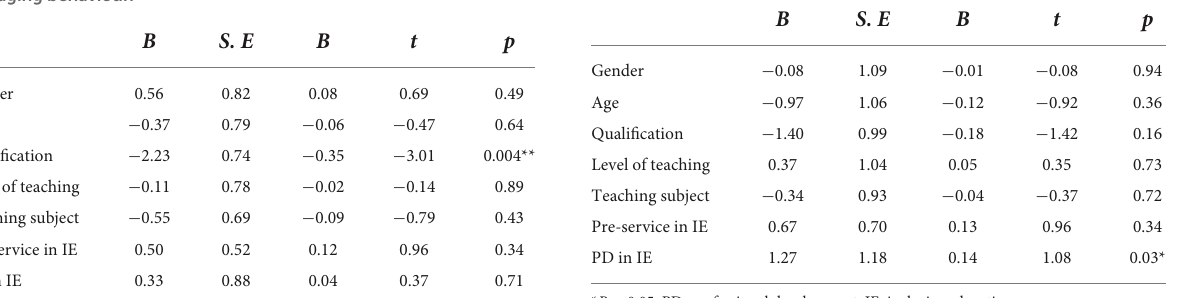
TABLE 6 Summary of demographics regressed on